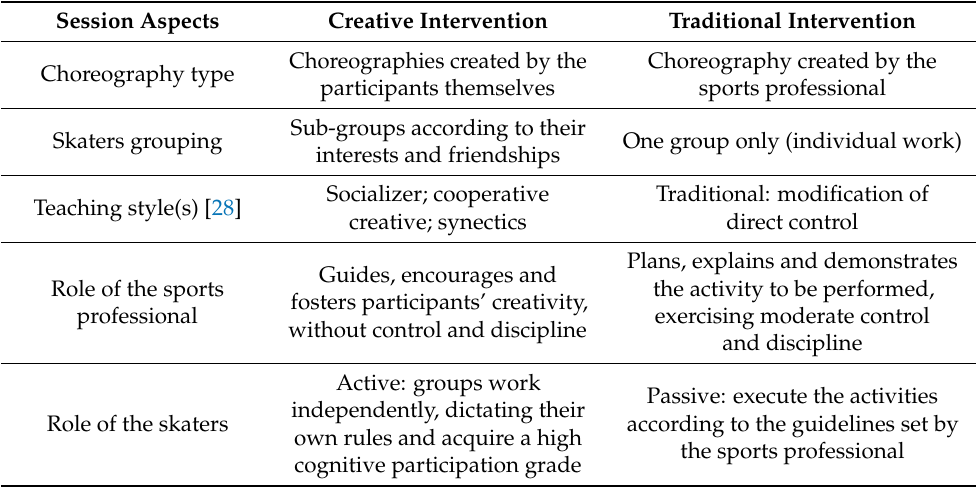
Table 1. Characteristics of creative and traditional